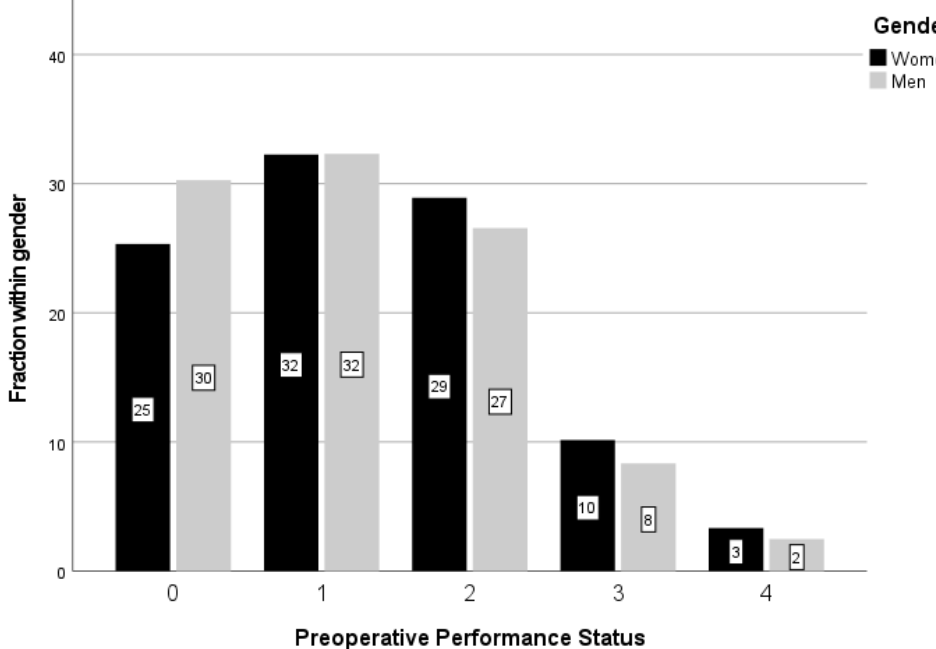
Figure 2. WHO preoperative performance status (PPS) for men and women. Significantly more men had a better PPS ( p < 0.001) using the Chi square test. The fraction within each sex is reported in percent (%). We found no significant differences for the type of surgery performed in males and females during the investigated period, with 26.7% of males having a biopsy versus 26.3% of females. The corresponding percentages for partial resection were 40.1% and 39.3%, and for radical resection 33.3% and 34.4% ( p = 0.71).